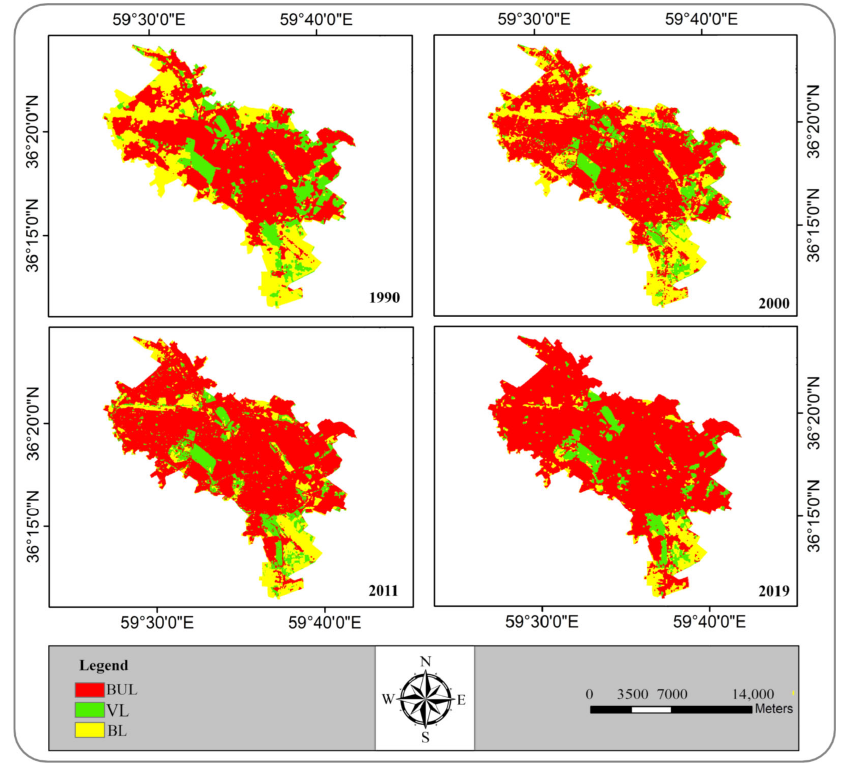
Figure 4. LU/LC maps of Mashhad for 1990 ( top left ), 2000 ( top right ), 2011 ( bottom left ), and 2019 ( bottom right ) with three distinguished LU/LC classes, namely, built-up land (BUL), vegetated land (VL), and bare land (BL).